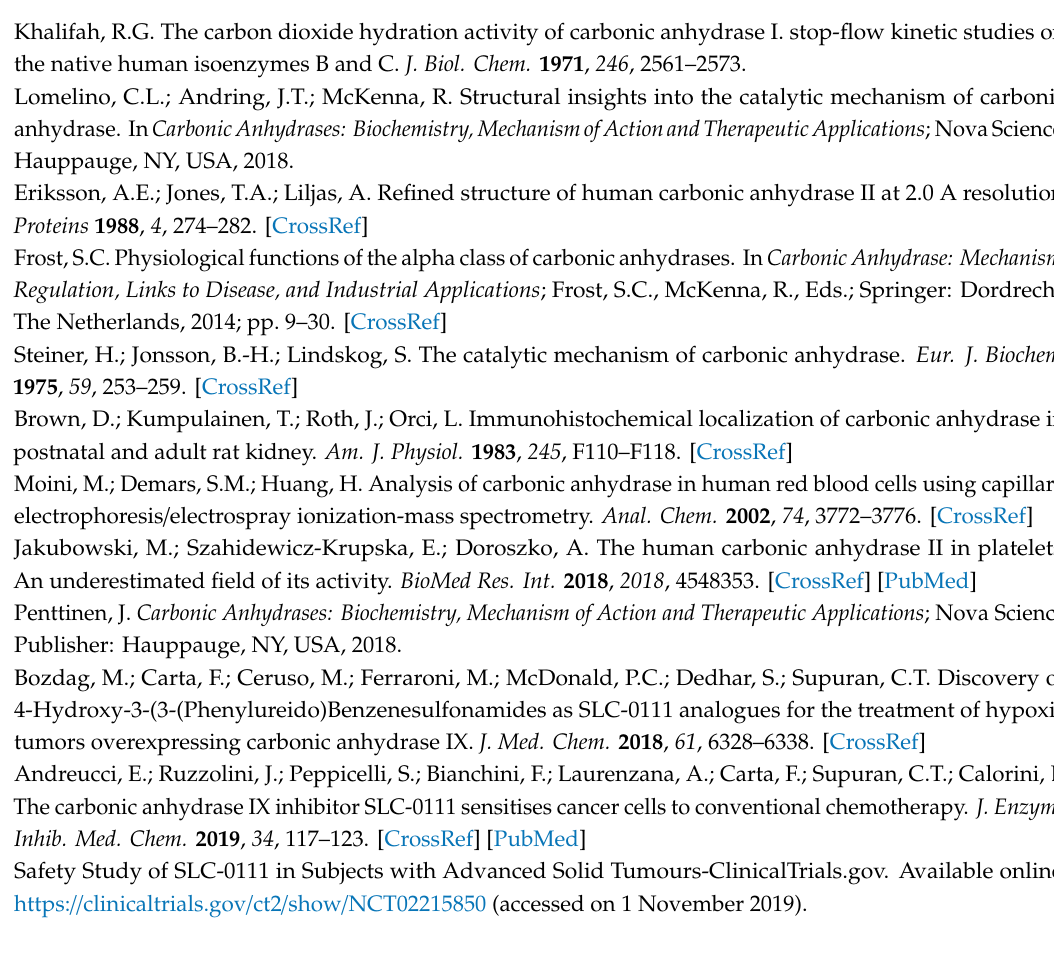
Table S1: CAII-SA crystallization